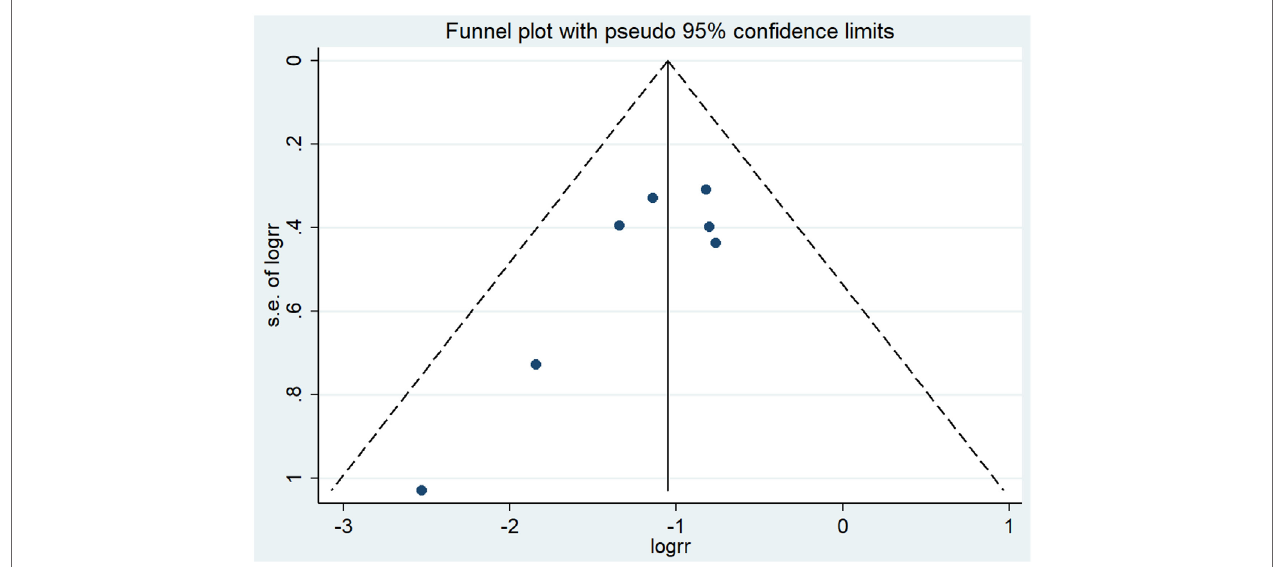
FigURe 3 | Results of the funnel plot of RCTs evaluating the effect of PCI on BM in NSCLC. Abbreviations: logrr: logarithm of the relative risk; RCTs, randomized controlled trials; PCI, prophylactic cranial irradiation; BM, brain metastases; NSCLC, non-small cell lung cancer.